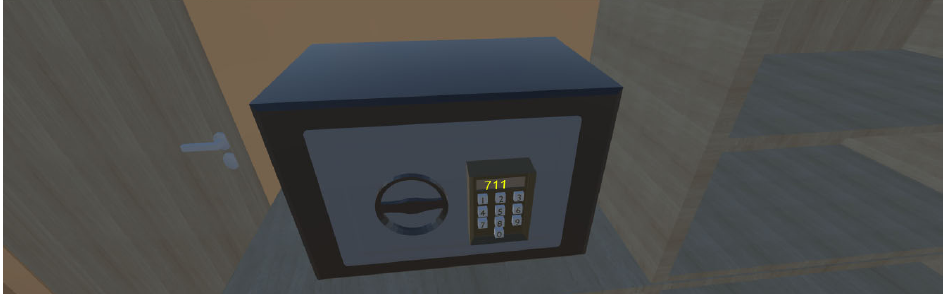
Figure 10. Image showing the digitation of the code needed to open the safe.